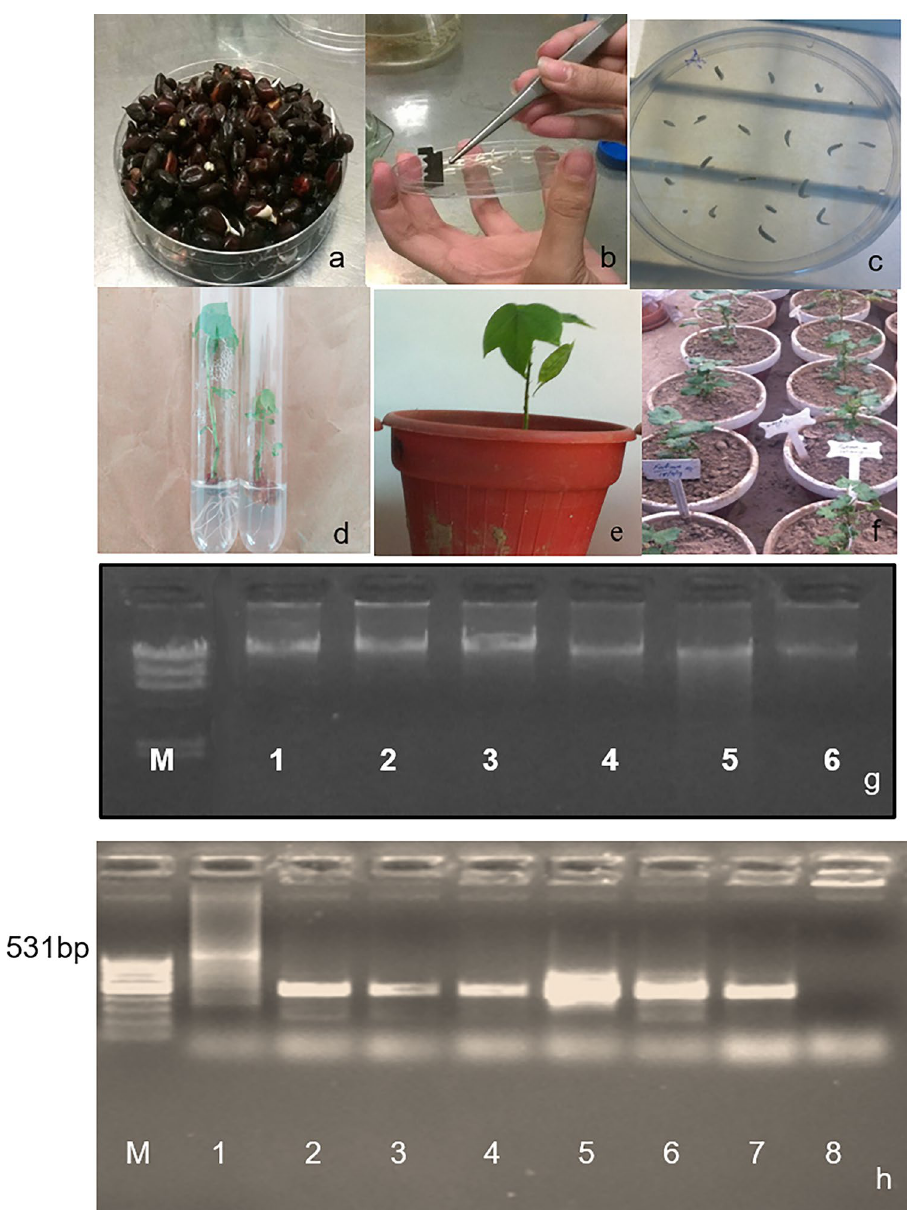
Figure 4. ( a-f ) Agrobacterium mediated Transformation of GaZnF in Gossypium hirsutum and Molecular analysis of transgenic plants. ( a ) Seed Germination, ( b ) A cut was given at apical meristem of isolated embryos from seeds and co-cultivation with Agrobacterium containing GaZnF, ( c ) Embryos on media containing plates, ( d ) Plants with developed shoots and roots, ( e ) Shifting of plants in soil containing pots, ( f )shifting of pots containing plants in Green house for acclimatization. ( g,h ). Genomic DNA extraction and PCR amplification T0 generation. ( g ) Genomic DNA of transgenic and control plants, M. λ DNA/Hind III, Lane 1–6. Genomic DNA of GaZnF gene, ( h ) PCR amplification of genomic DNA of T0 generation’s transgenic and control cotton plants, Lane M was 100 bp Marker (Thermo scientific Cat. No.SM0241), Line 1,2,3,4,5 and 6 were Lane PF0022,